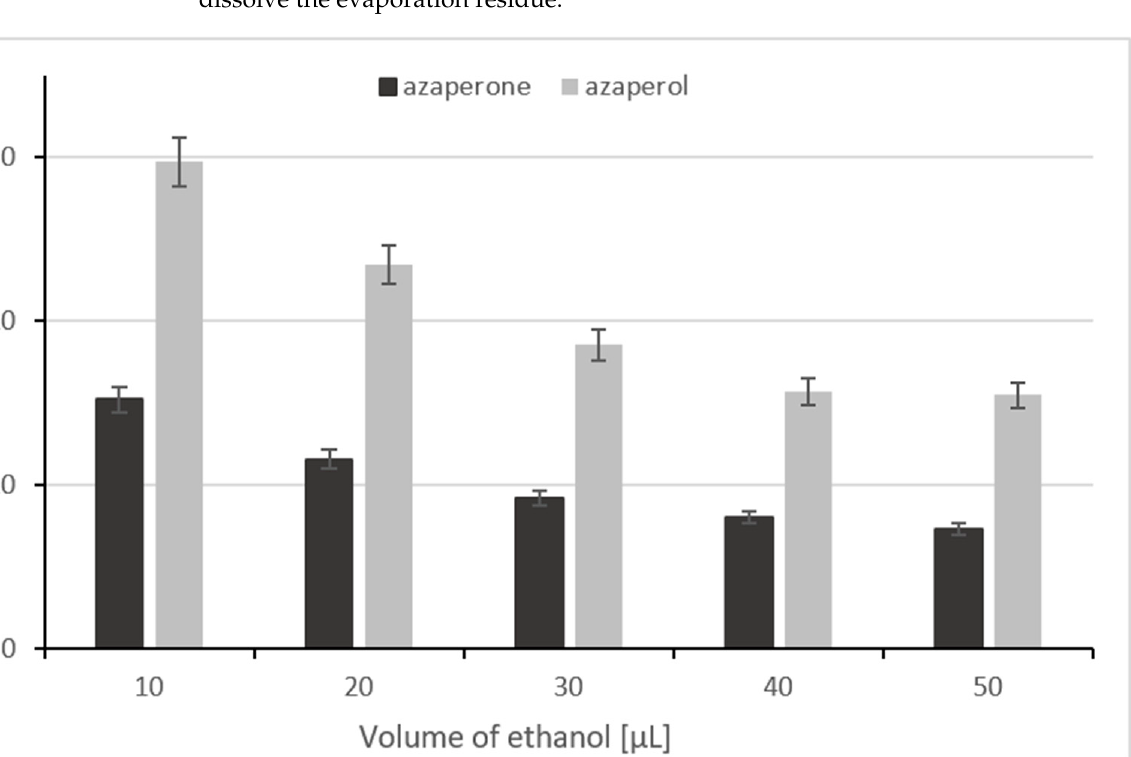
Figure 3. The relationship between the peak height and the temperature during lyophilization.